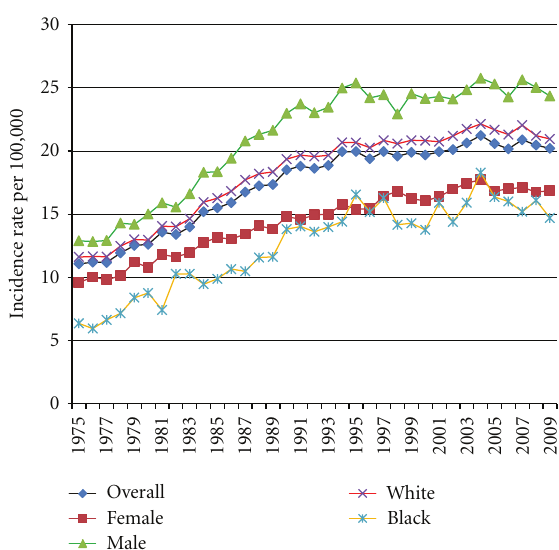
Figure 1: Temporal trends in the age-adjusted incidence rate of non-Hodgkin lymphoma in the United States based on SEER data, 1975–2009.